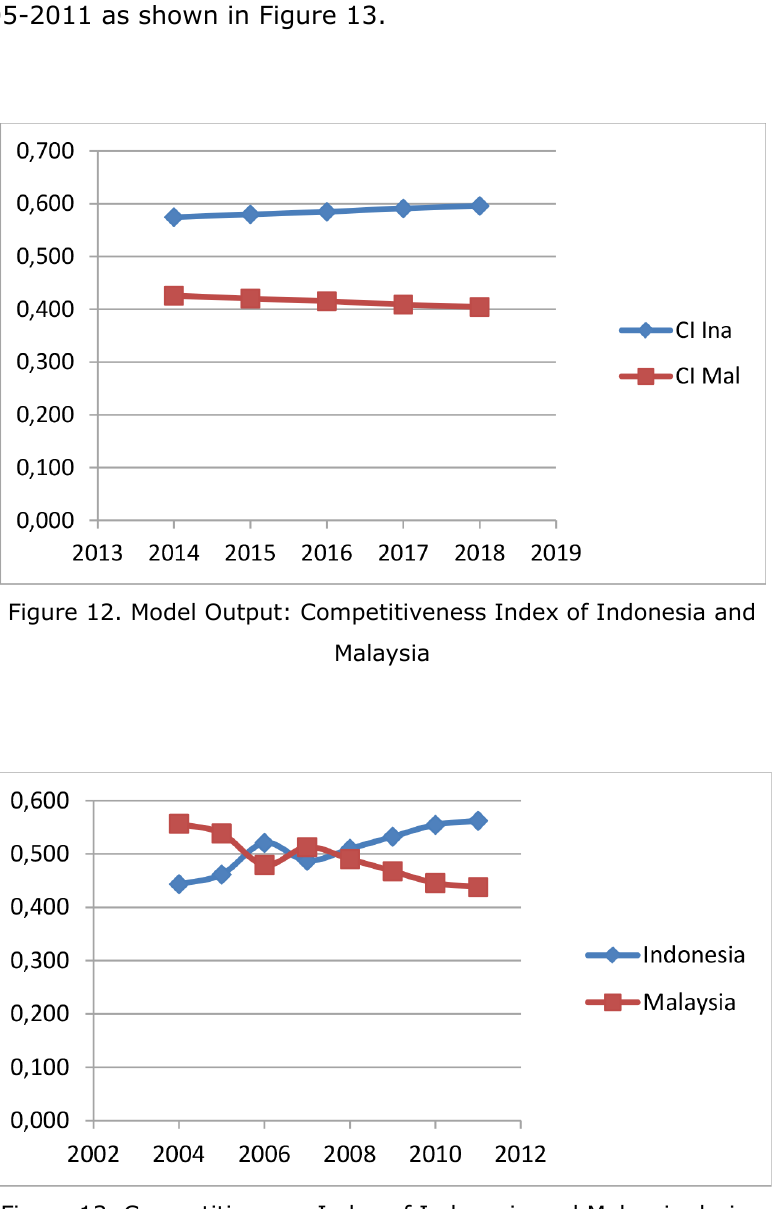
Figure 13. Competitiveness Index of Indonesia and Malaysia